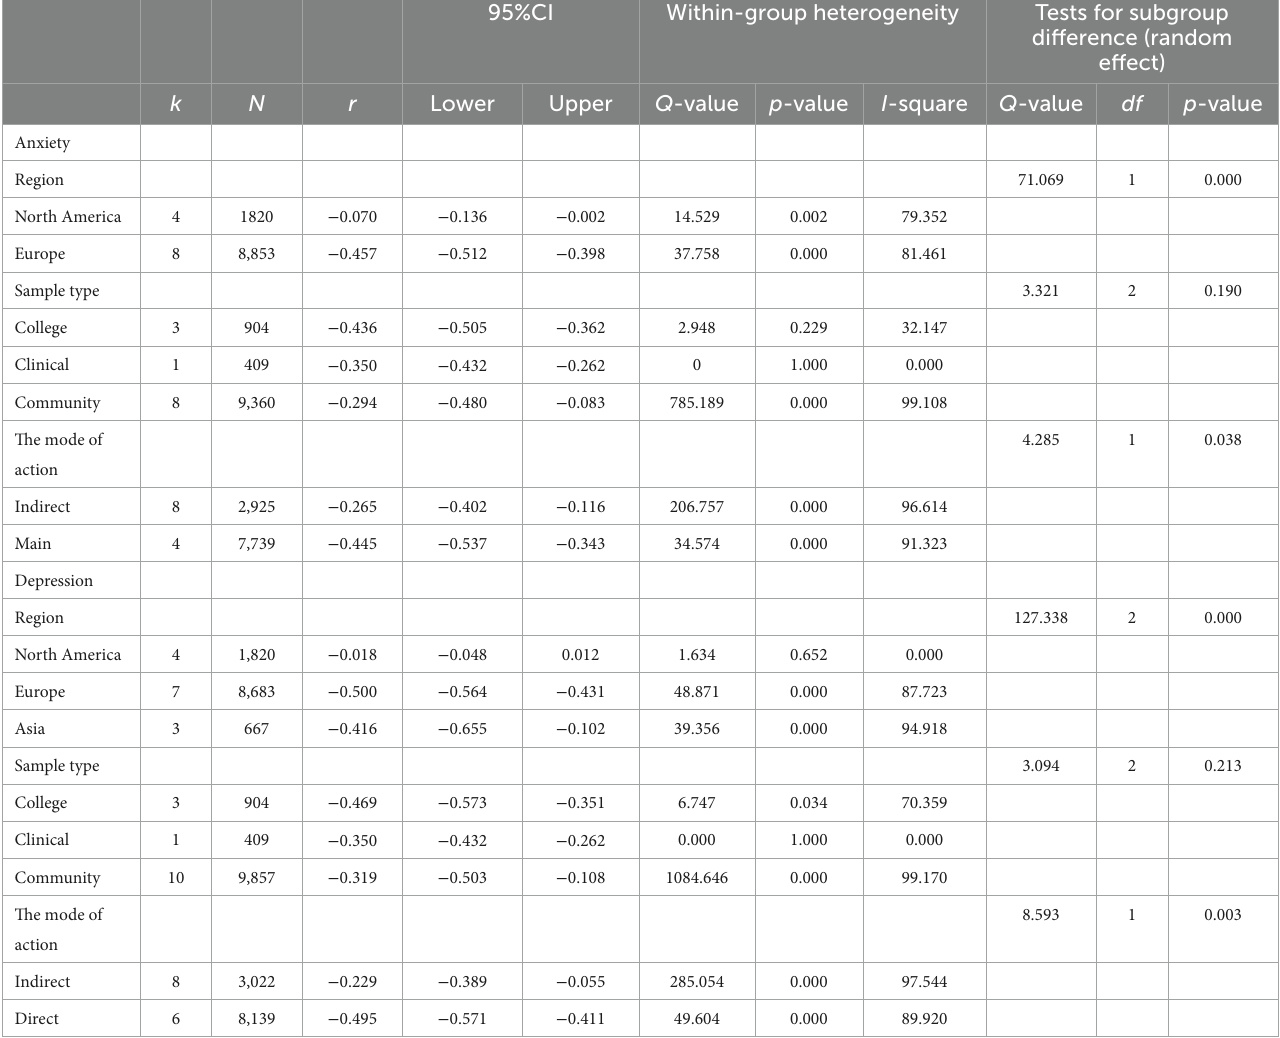
TABLE 5 Moderation